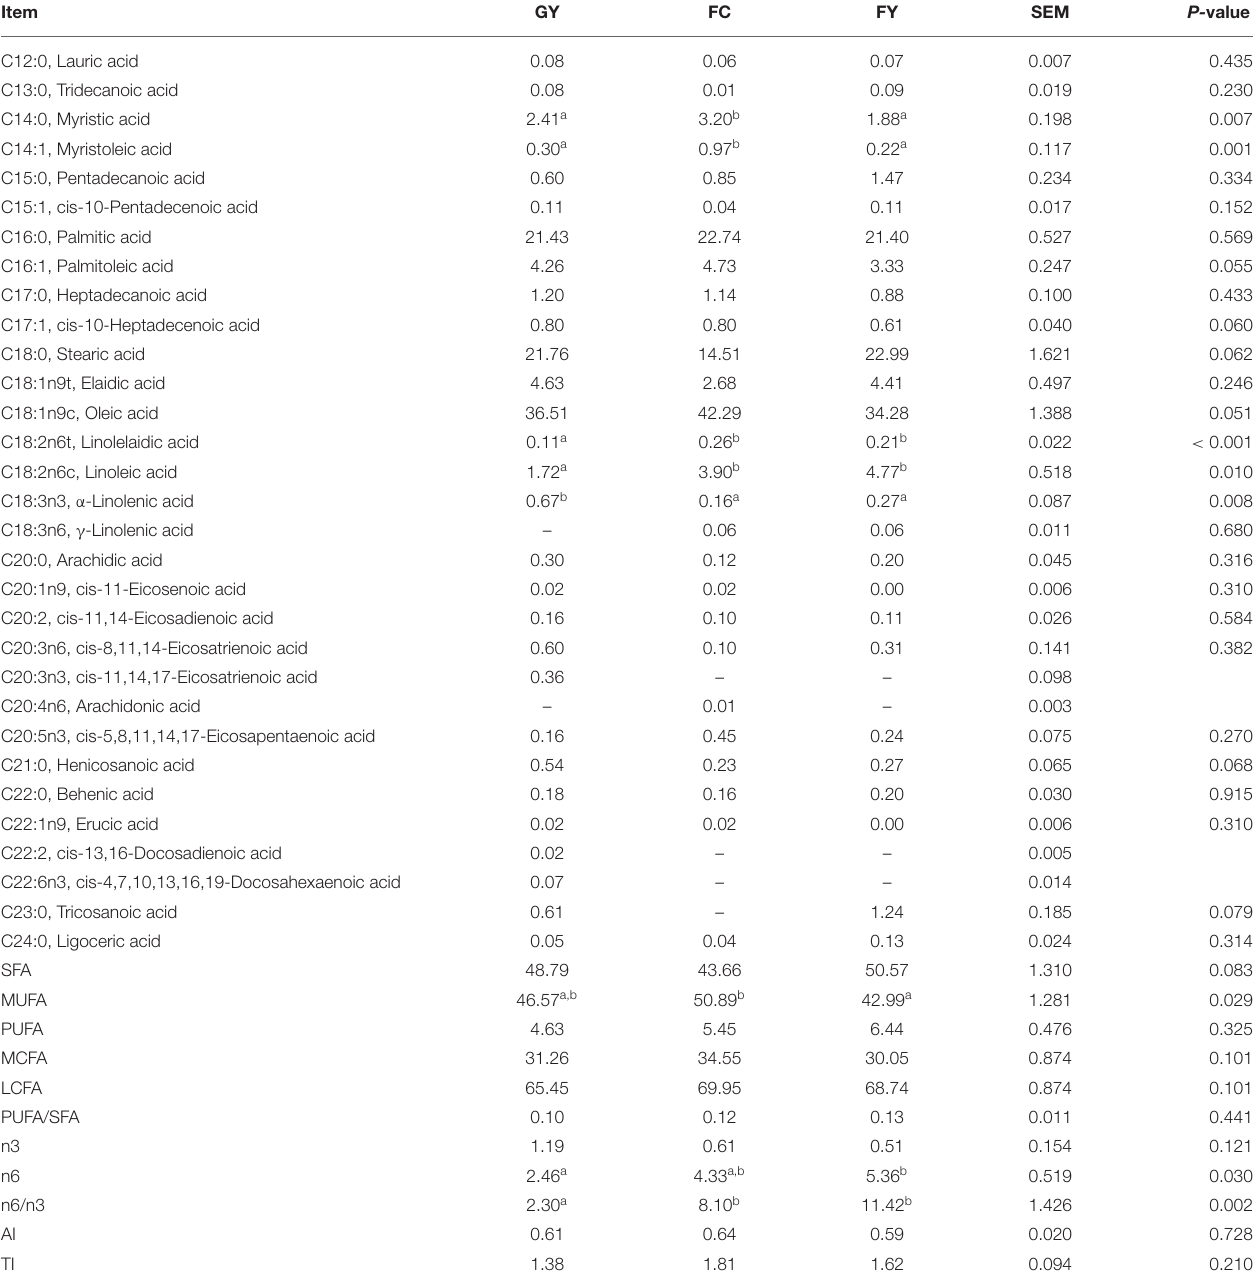
TABLE 6 | Fatty acid composition (g/100g fatty acid methyl) of Longissimus thoracis from GYs, FC, and FYs.